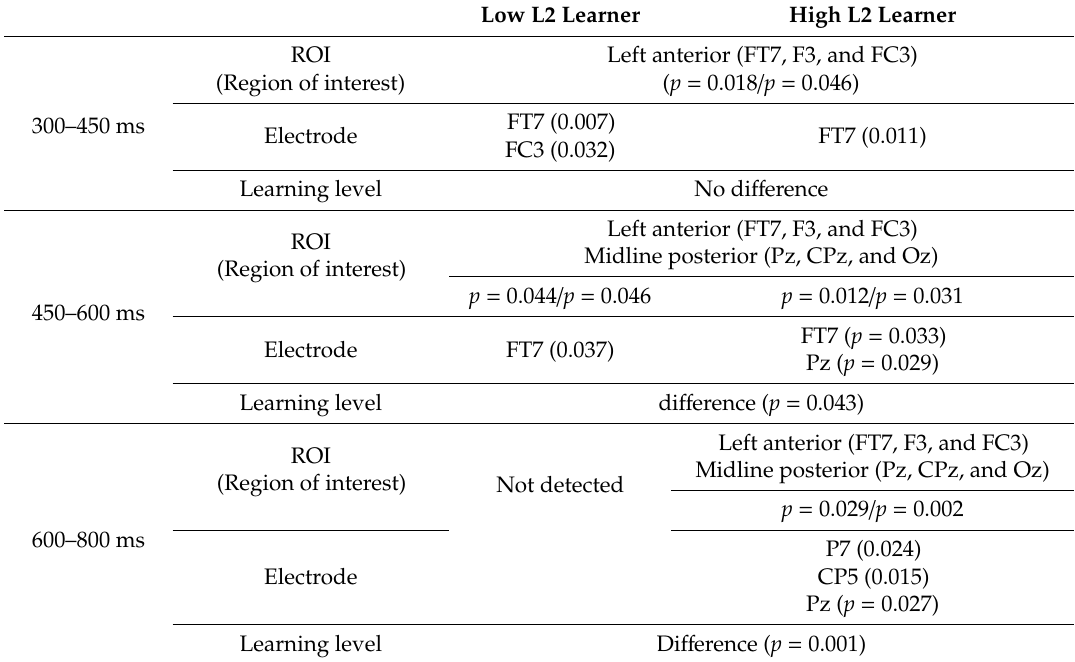
Table 5. ERP results using regions of interest (ROIs) by learning